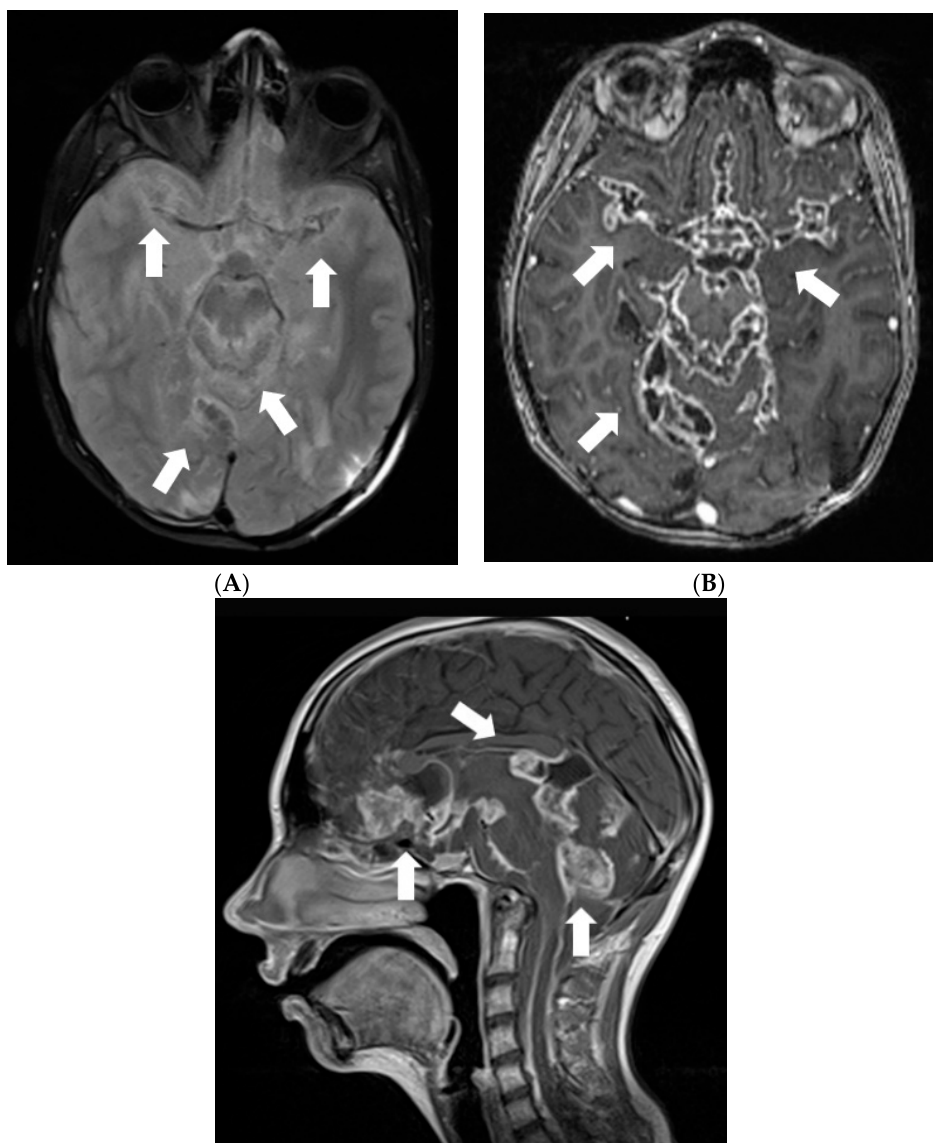
Figure 4. Follow-up MRI of the brain 2 years after the onset of symptoms (May 2013): ( A ) Axial T2W/FLAIR/FS, ( B ) axial, and ( C ) sagittal T1W postcontrast images demonstrate enlarged cystic lesions in the subarachnoid spaces causing compression of the brainstem and the fourth ventricle and vivid leptomeningeal enhancement extending to the spinal canal.